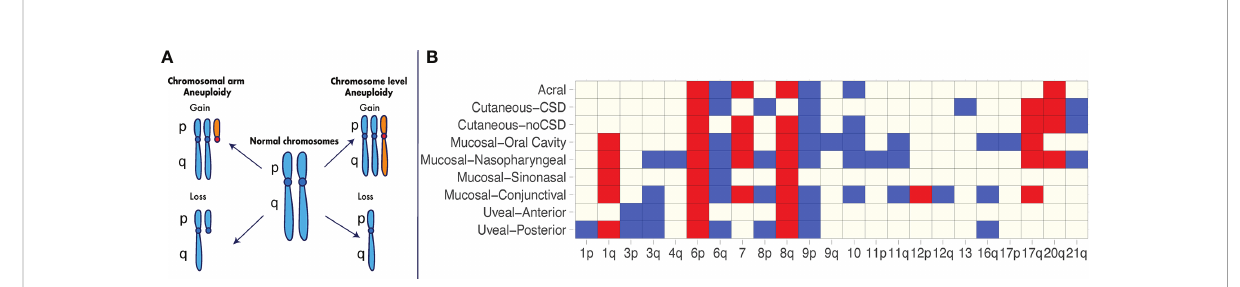
FIGURE 1 Recurrent aneuploidy events in melanoma. (A) Chromosome and chromosomal arm aneuploidy. Gained arms and chromosomes are illustrated in orange. Lost arms and chromosomes are depicted by a reduction in chromosomal content with respect to a normal karyotype. (B) Recurrent aneuploidy events across melanoma subtypes. Chromosomal arm and whole-chromosome gains and losses commonly observed within a speci fi c melanoma subtype are indicated in blue and red, respectively. Recurrent events are illustrated as identi fi ed across studies in acral melanomas (3, 4), cutaneous melanomas with and without chronic sun damage (CSD) (3), mucosal melanomas including nasopharyngeal (3), conjunctival (5, 6), sinonasal (7, 8) and oral cavity melanomas (9), uveal posterior (10) and uveal anterior melanomas (11 –